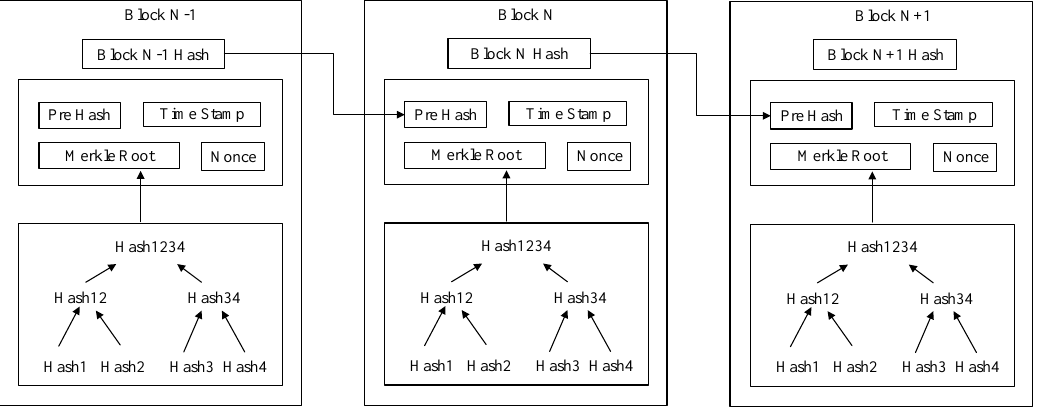
Figure 1. Process of secure storage.